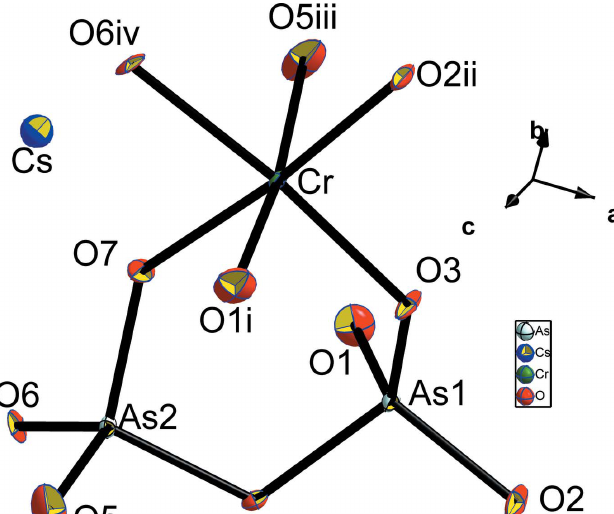
Figure 1 The coordination polyhedra around Cr and As atoms in the title structure. Displacement ellipsoids are drawn at the 50% probability level. [Symmetry codes: (i) x , 1 (cid:2) 1 + z ; (iv) 1 (cid:2) x , 1 2